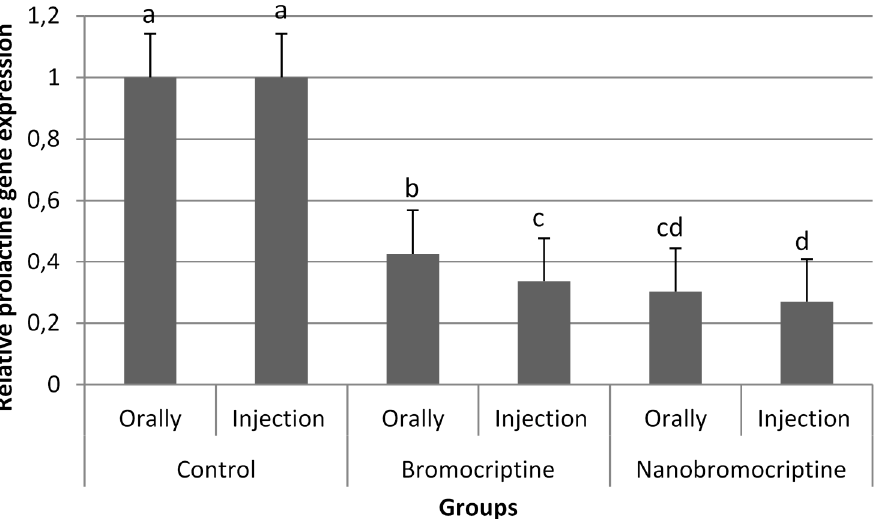
Figure 4. Quantitative gene expression of prolactin gene in pituitary after either bromocriptine or nano-bromocriptine administration. The qRT-PCR data were normalized relative to the expression of glyceraldehyde-3-phosphate dehydrogenase (GAPDH) as endogenous control and calculated using the 2 − ∆∆ CT method ( n = 5). Different superscripts indicated significant differences at p < 0.05. Error bars indicate the standard error of the mean.